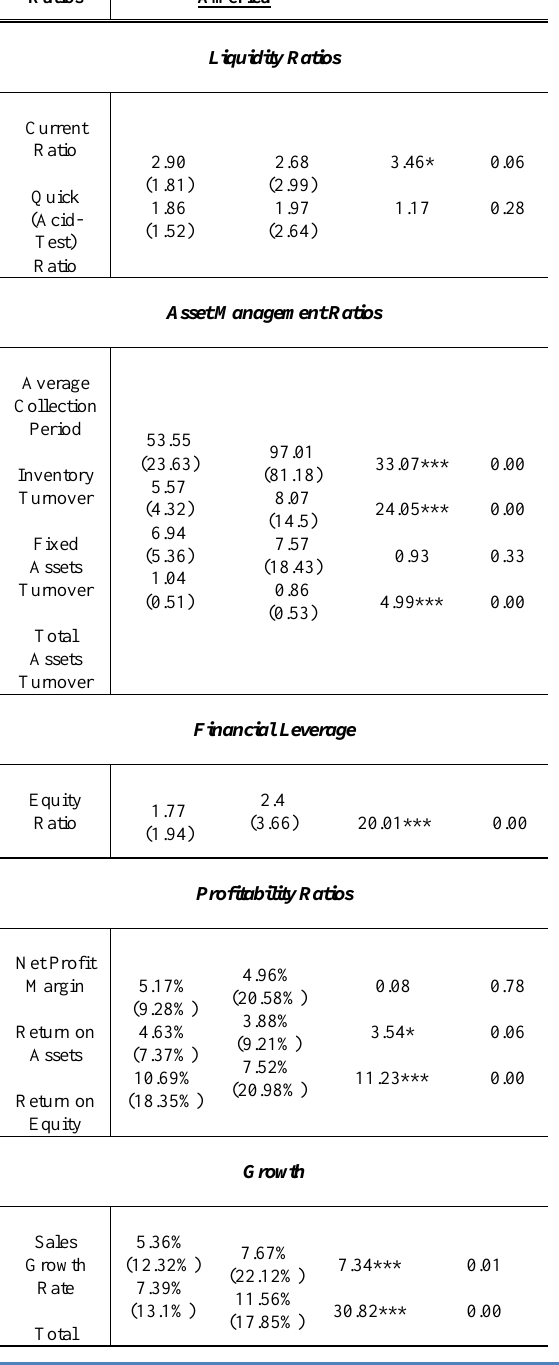
the table indicates that the overall financial characteristics of NAFTA and Latin manufacturing firms are significantly different at the 1- percent level. Table 6: MANOVA Statistics Univariate Means and Standard Statistics Deviations† F-Value P- Financial NAFTA Latin Ratios America